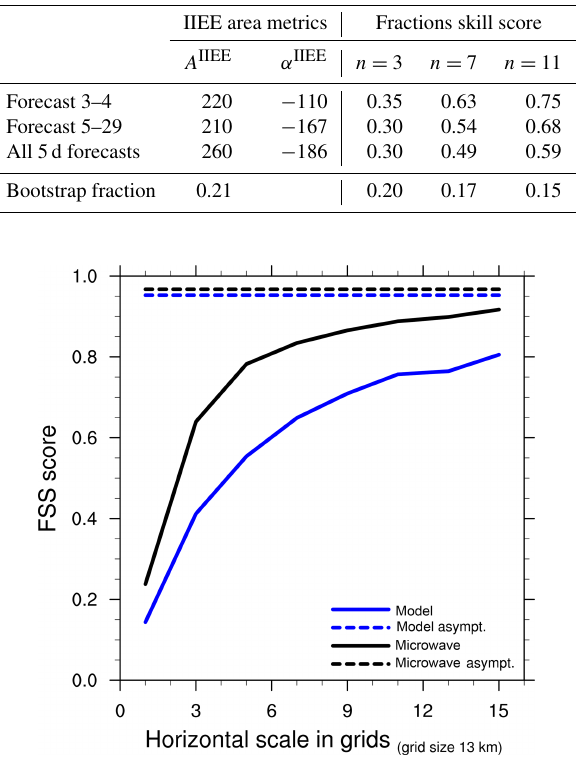
Figure 8. Fractions skill score as a function of resolution for 5d lead time model forecasts vs. ice chart data (blue line) and mi- crowave data vs. ice chart data (black line). Dashed lines show the asymptotic FSS values as defined by Roberts and Lean (2008) (their Eq. 8). These results are based on forecast bulletins and microwave data from January 2017 to mid-May